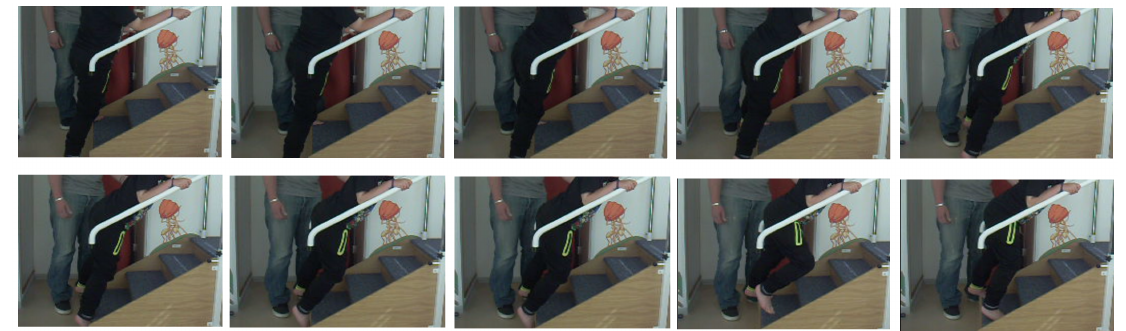
Figure 12. Example of one stairs step progression every half second of patient 5.